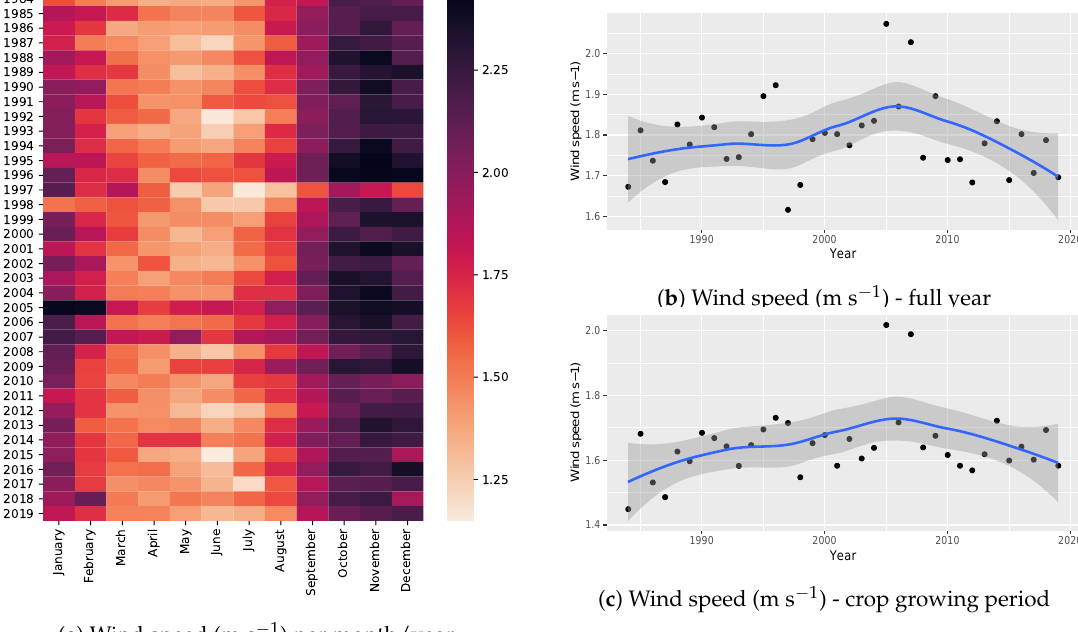
Figure A7. Time series of average wind speed (m s − 1 ) in Los Rios from 1984 to 2019. ( a ) Heat-map of wind speed (m s − 1 ) per each month and year. The color scale represents the wind speed in m s − 1 . ( b ) Wind speed averaged during the full year. ( c ) Wind speed averaged during the maize crop growing period in Ecuador (January–May). Each dot represents one record, the blue line shows the smoothed time series and the shaded area represents the 95% confidence